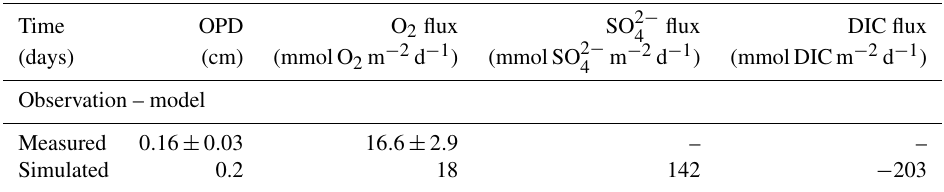
Table 4. Model vs. data comparison for oxygen penetration depth (OPD), flux of oxygen, sulfate, and DIC (26d after